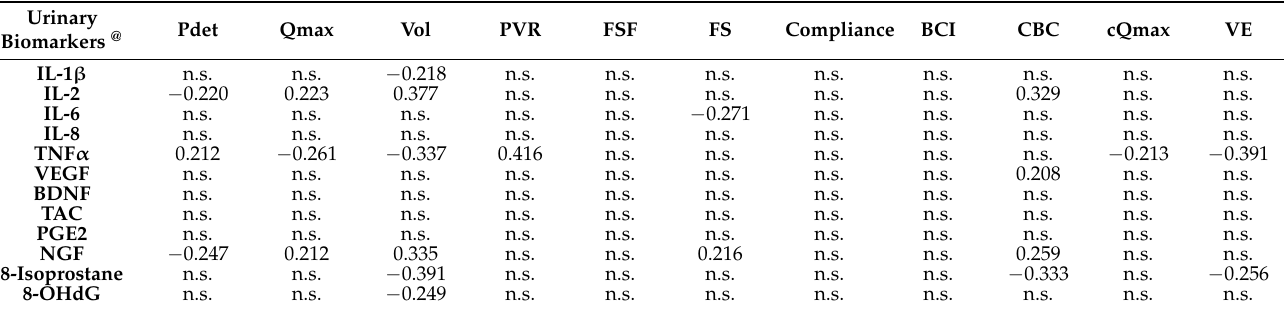
Table 6. The correlation coefficient (r value) between the urinary biomarker levels and clinical characteristics of patients with USI and DO.